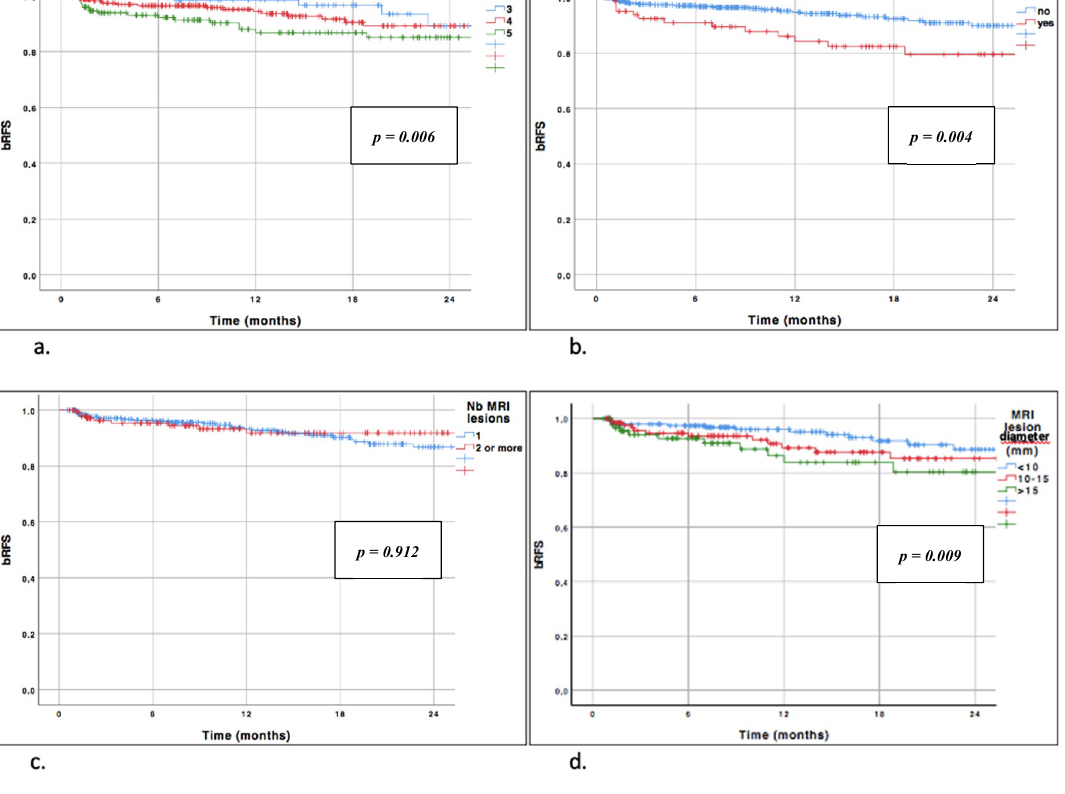
Figure 1. Biochemical recurrence free curves stratified by MRI characteristics. ( a ) Biochemical recurrence free curves stratified by PI-RADS. Log rank test p = 0.006. ( b ) Biochemical recurrence free curves stratified by IRM extracapsular extension. Log-rank test p = 0.004. ( c ) Biochemical recurrence free curves stratified by number of MRI lesions. Log-rank test p = 0.912. ( d ) Biochemical recurrence free curves stratified by MRI lesion diameter. Log-rank test p = 0.009. ( e ) Biochemical recurrence free curves stratified by grade group on targeted biopsy. Log-rank test p = 0.001. bRFS = biochemical recurrence free survival; iECE = extracapsular extension on MRI; MRI: magnetic resonance imaging; Nb MRI lesions = number of MRI lesions; GG on TB = grade group on targeted biopsies; PI-RADS: prostate imaging and reporting and data system.